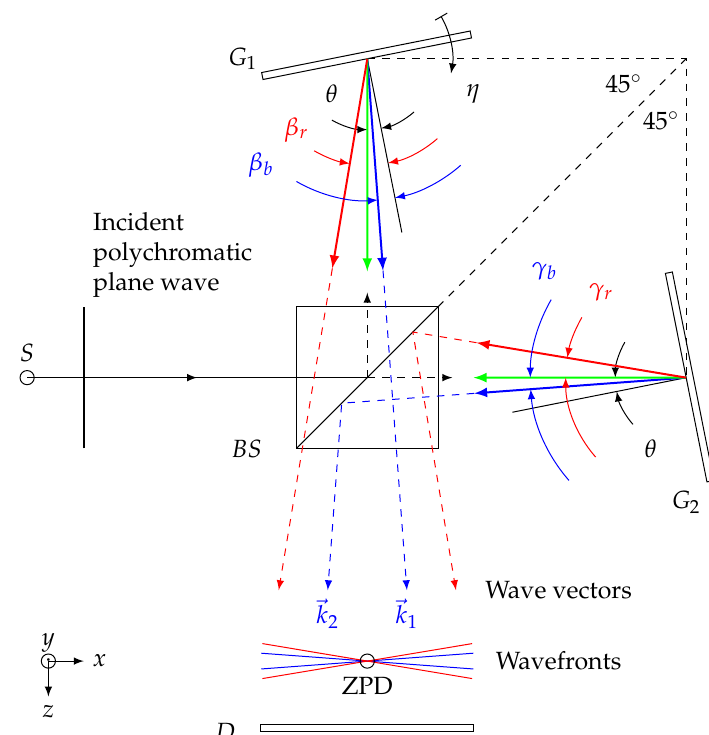
Figure 1. Illustration of the basic principle of spatial heterodyne spectroscopy (SHS): S is the light source, BS is the cube beam splitter, G 1 and G 2 are the gratings, rotated by the angle θ with regards to the optical axes, D is the detector plane, and ZPD is the zero-path-difference line (this line is parallel to the grooves in the grating, i.e., axis y ), and wave vectors (cid:126) k 1 and (cid:126) k 2 for an incident monochromatic wavefront, as seen from the detector. Grating G 1 is tilted for a very small angle η with respect to the y axis. Note that the directions of γ r = β r − θ and γ b = β b − θ are opposite, designating that these angles—which correspond to wavefronts on the opposite side of the spectrum with regards to the wavefront at Littrow configuration—have different signs. Lenses that collimate the light from the source and those that image the interference fringes on the detector are not